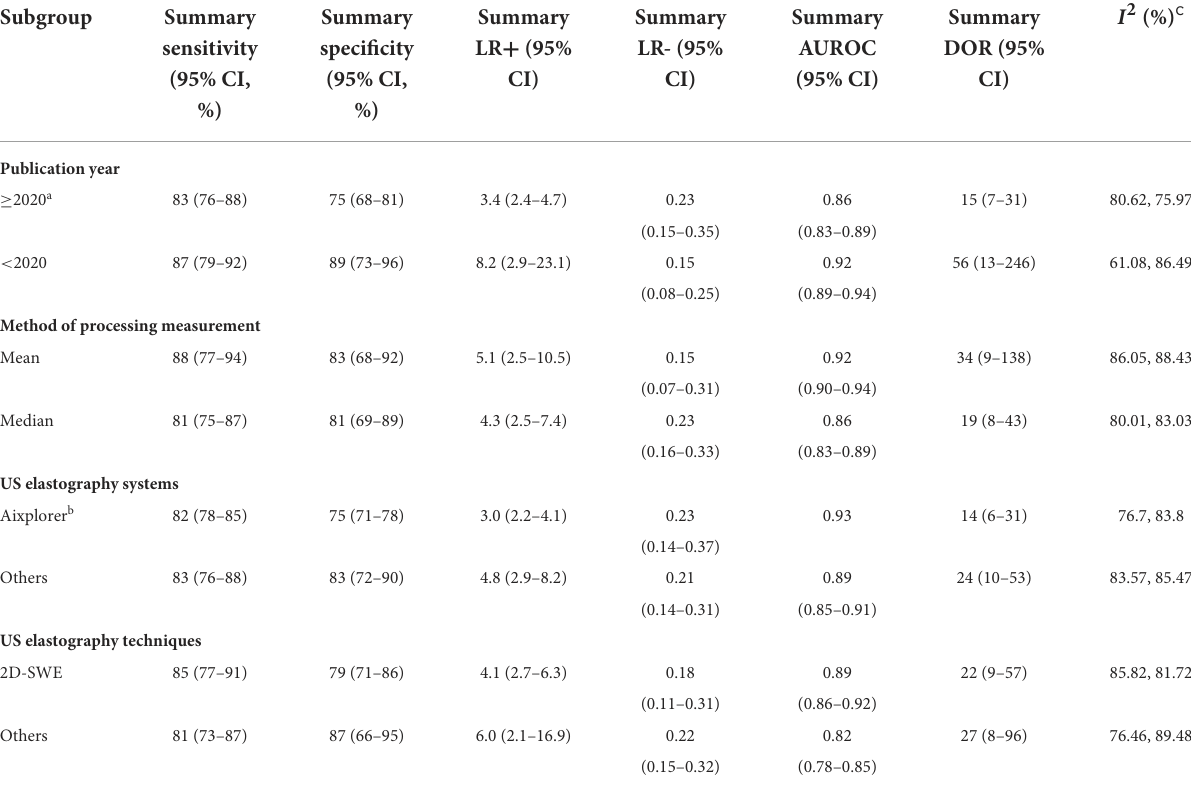
TABLE 5 Summary results of subgroup analysis for ultrasound elastography in the diagnosis of